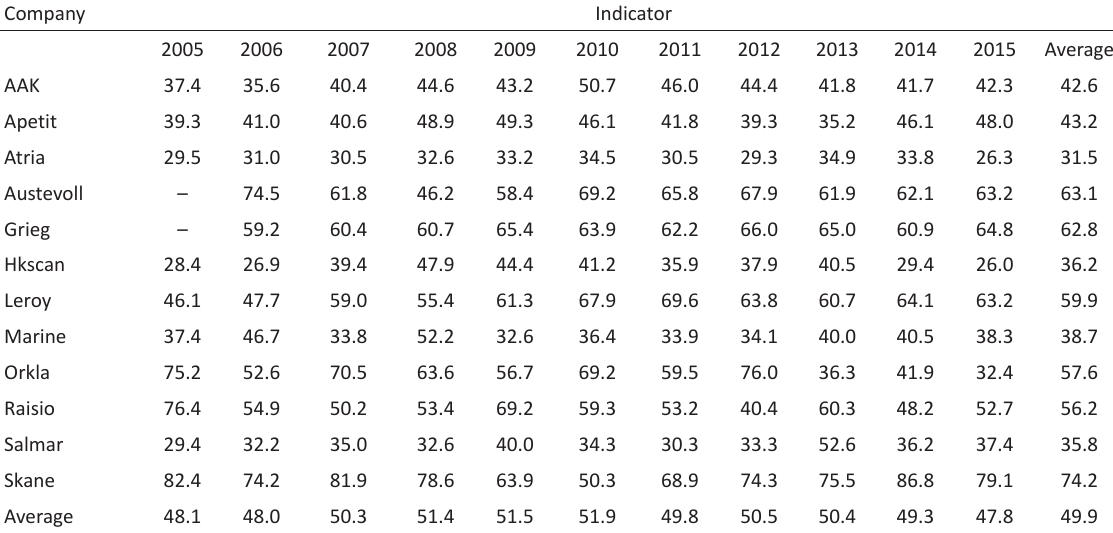
Table 2. The sub-indicator of current assets (A1) of food companies from Northern